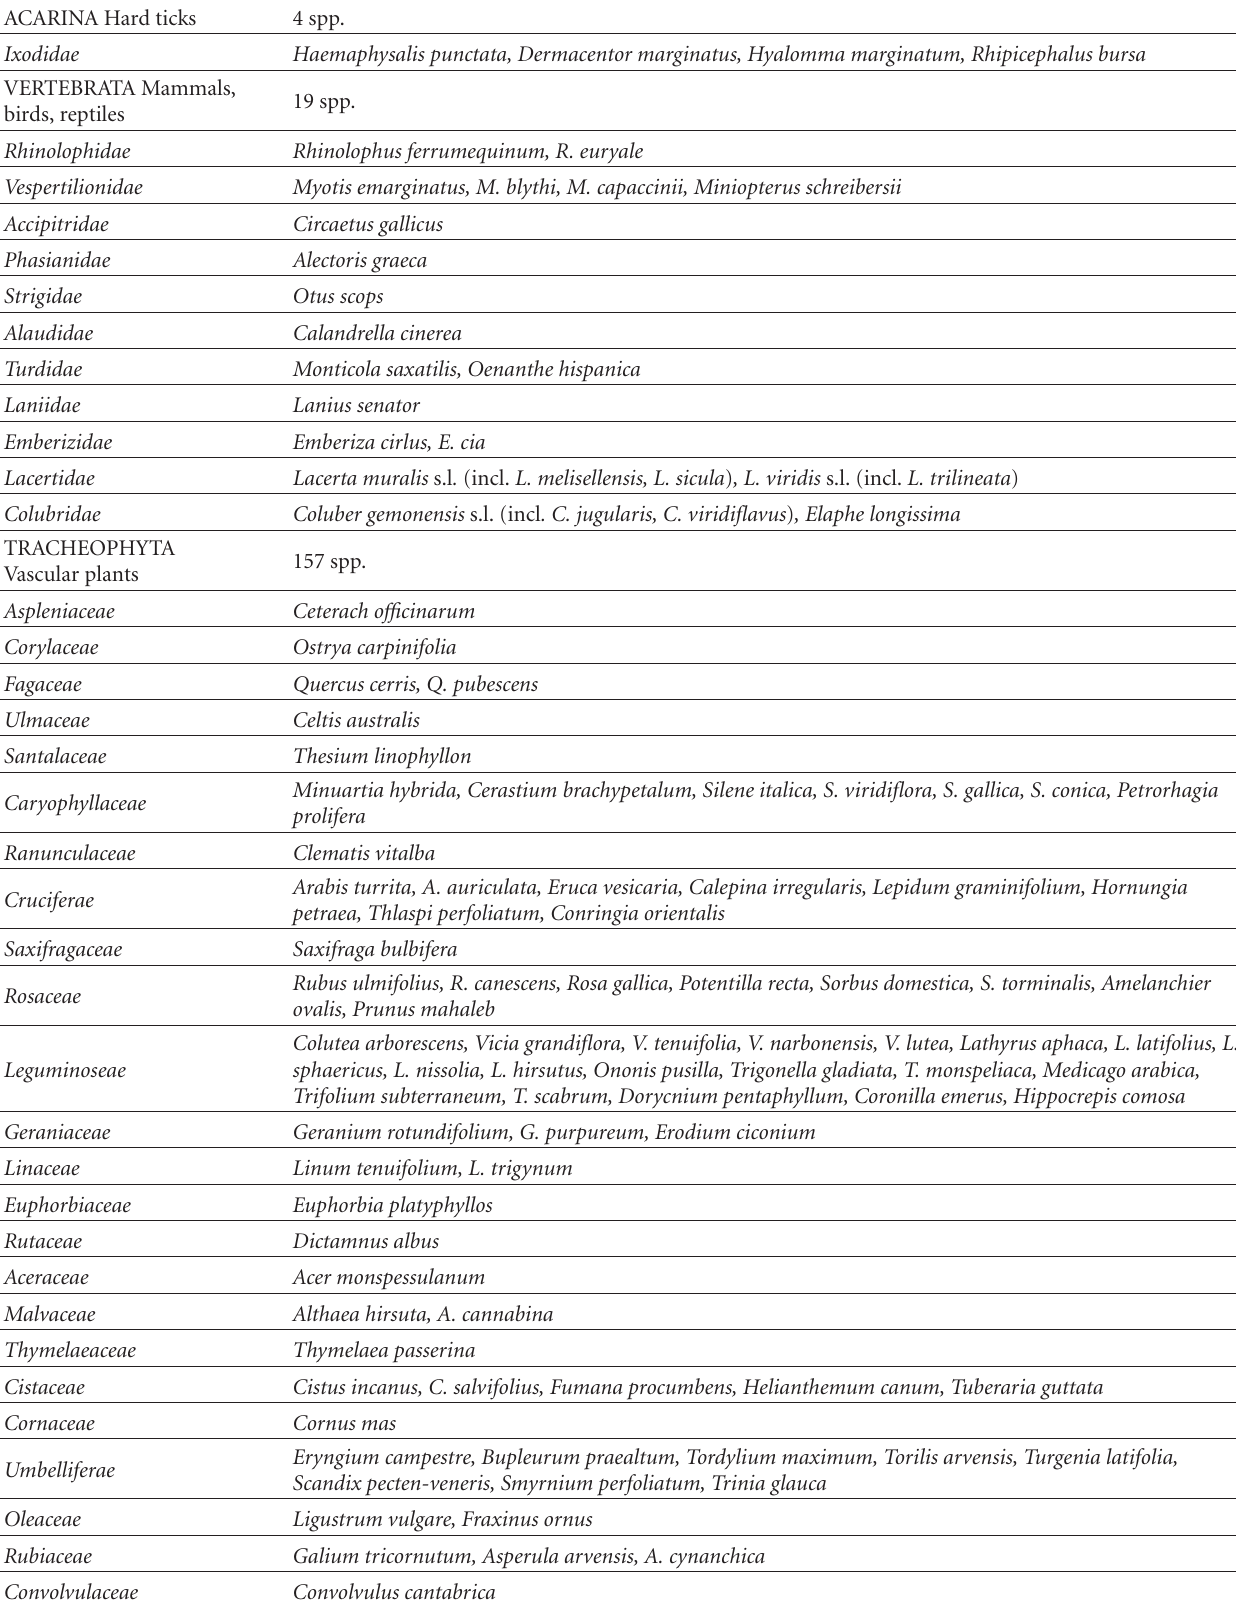
Table 2: Bioindicator species of the potential Bhanja virus occurrence in Europe. ACARINA Hard